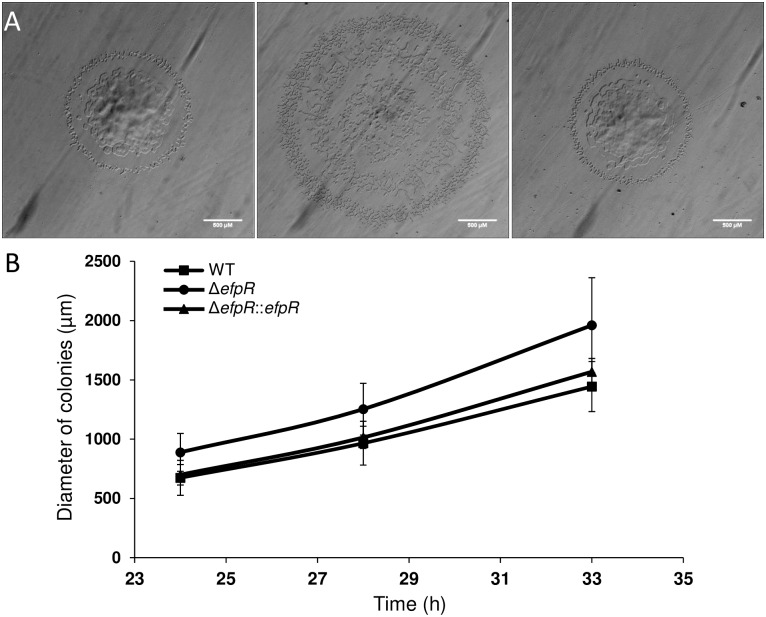
Deletion of efpR results in improved twitching motility of R. solanacearum GMI1000.(A) Typical morphology of R. solanacearum colonies after 33h incubation on BG medium plates (WT, ΔefpR and ΔefpR::efpR respectively from left to right). (B) The diameter of colonies has been measured through the time. The experiment was repeated twice, with twenty colonies for each strain per replicate. Bars indicate standard deviation.